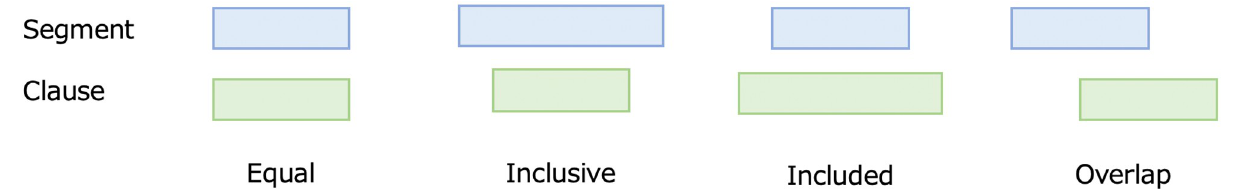
Fig 4. The four types of relationship between clause and clinical segment.